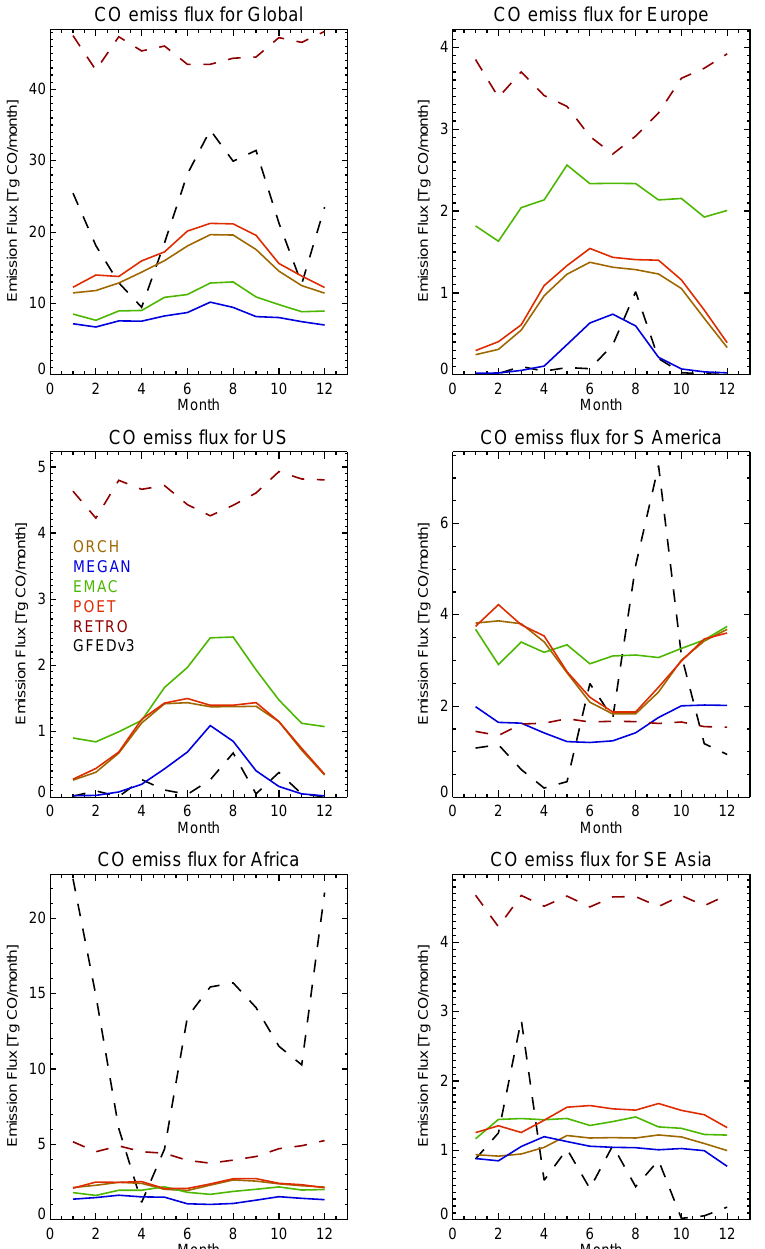
Fig. 2a. The seasonal cycle for CO emissions from 4 biogenic climatologies (solid lines), anthropogenic origin (RETRO, red dashed line), and biomass burning from GFEDv3 (dashed line) at global (top left) and regional (other panels) scales. The colour key is given in the inset of one of the